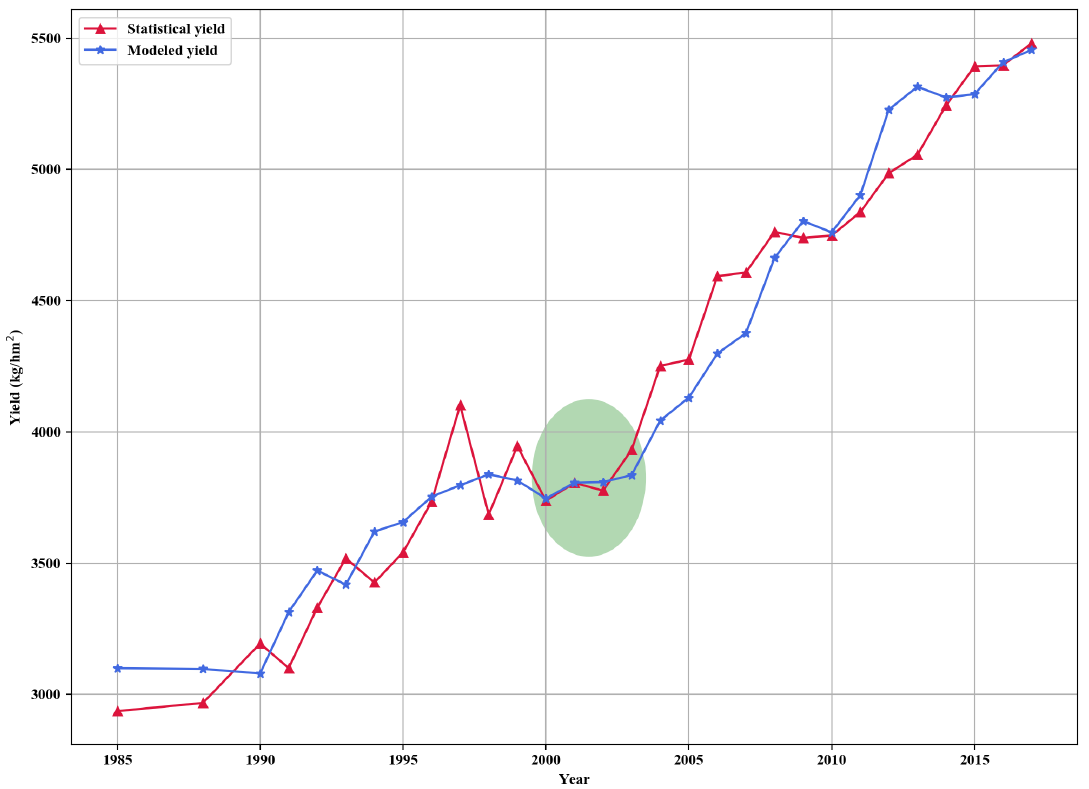
Figure 13. Linear regressed yield of China with input in agricultural production per Ha. The red line is the wheat yield of China collected from Nation Bureau of Statistics. The blue line is the linear regressed yield using agricultural inputs. The green oval contains the results of